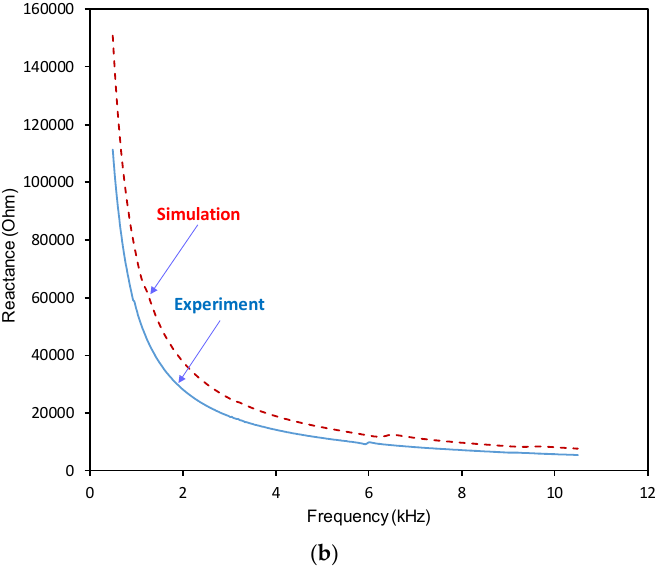
Figure 8. Electromechanical impedance response of the smart strand: simulation vs. experiment. ( a ) Real impedance (Resistance); ( b ) Imaginary impedance (Reactance).